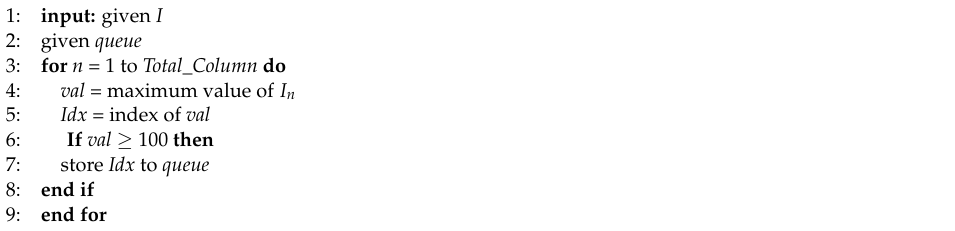
Algorithm 1. The search for the highest pixel value from every column of the image.